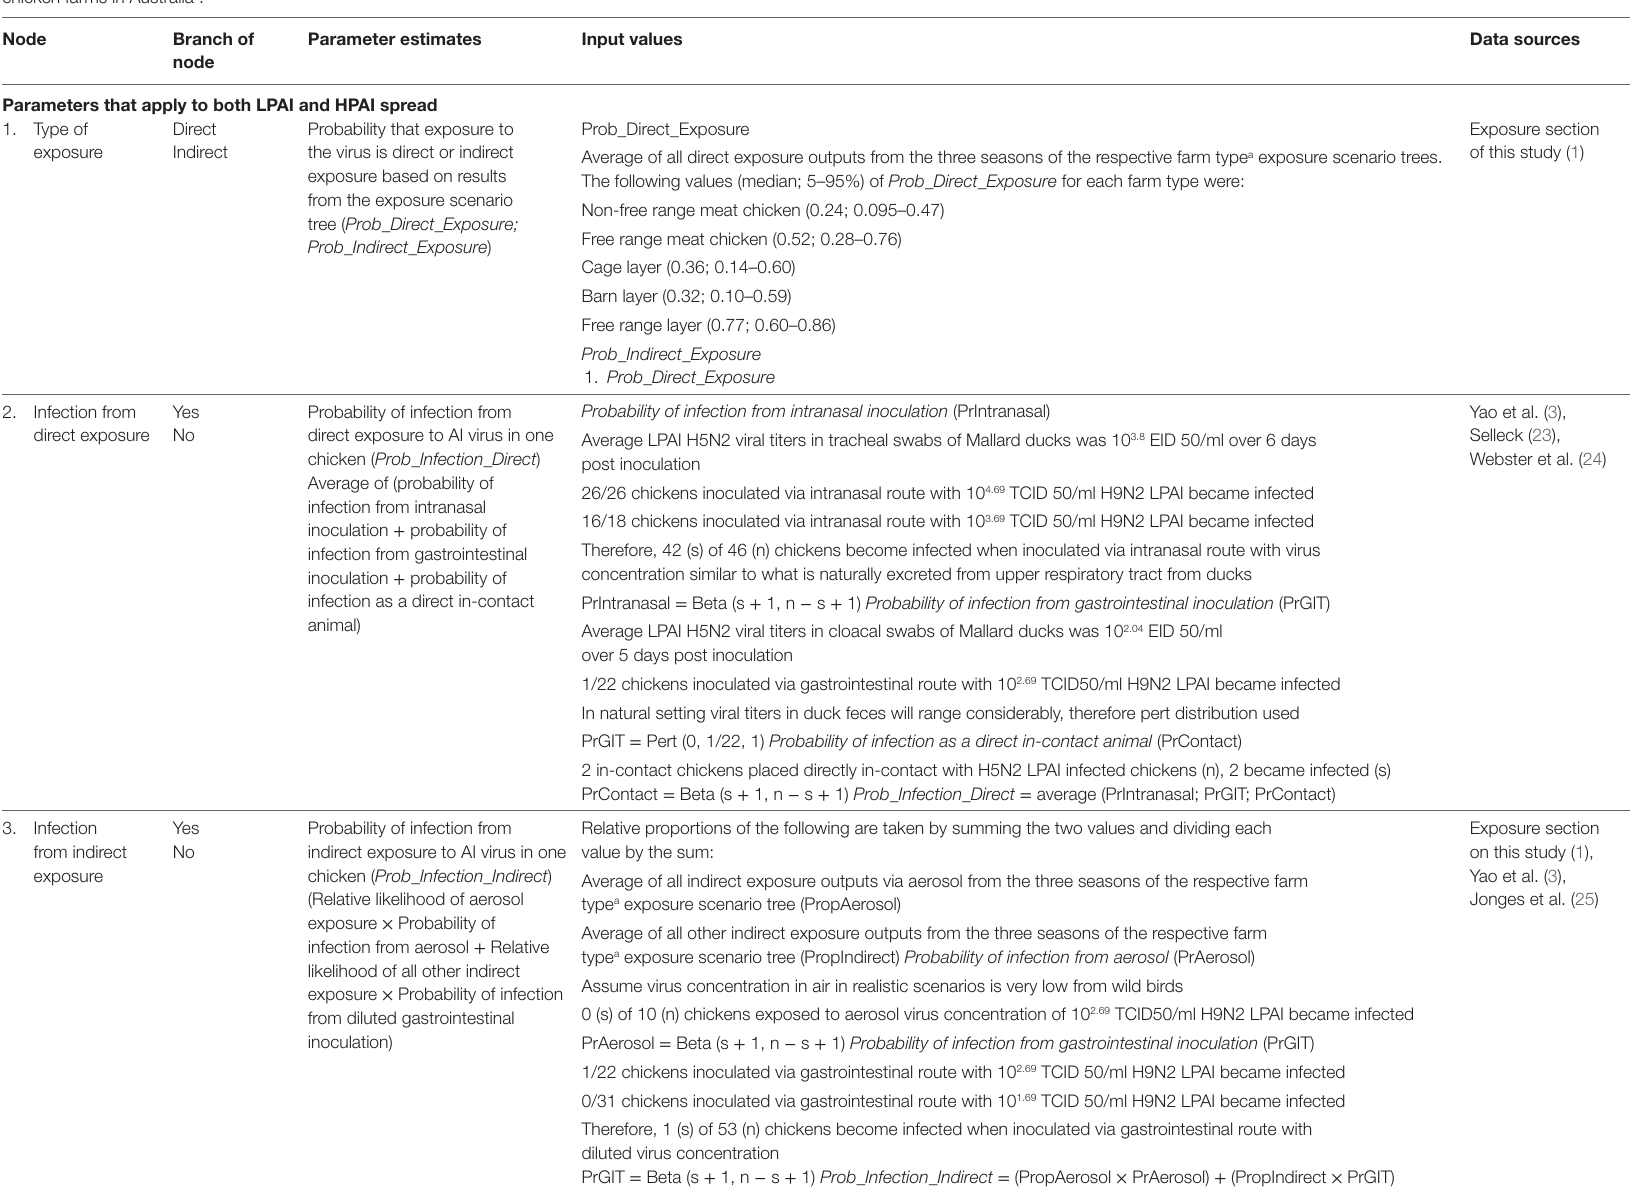
TaBle 1 | Nodes, parameter estimates, and input values used for the partial consequence assessment estimating the probability of spread of Avian Influenza (AI) viruses from flocks on both layer and meat commercial chicken farms in Australia a .